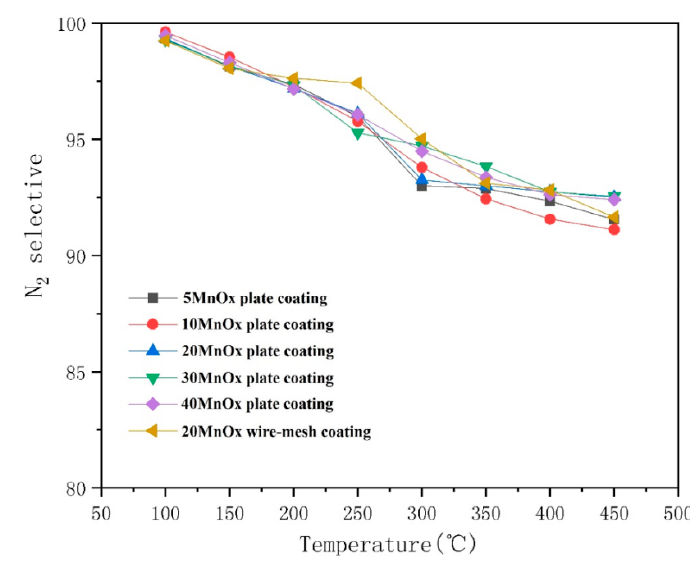
Figure 14. The nitrogen (N 2 ) selectivity of different catalytic coatings.